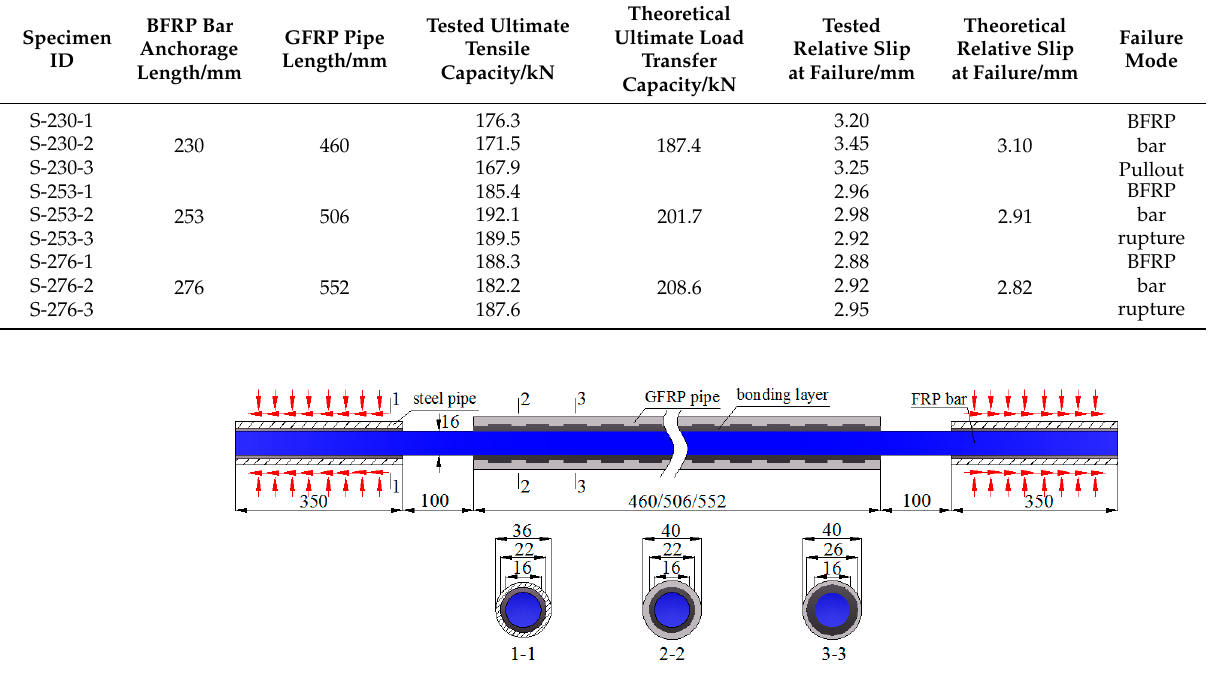
Figure 10. Specimen configurations (Unit in mm). Table 3. Specimen details and the corresponding tested results.